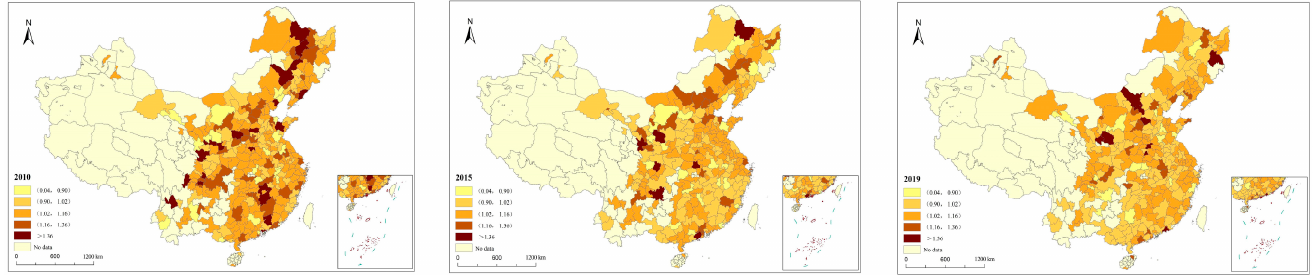
Figure 1. Spatial and temporal distributions of the urban green development efficiency.